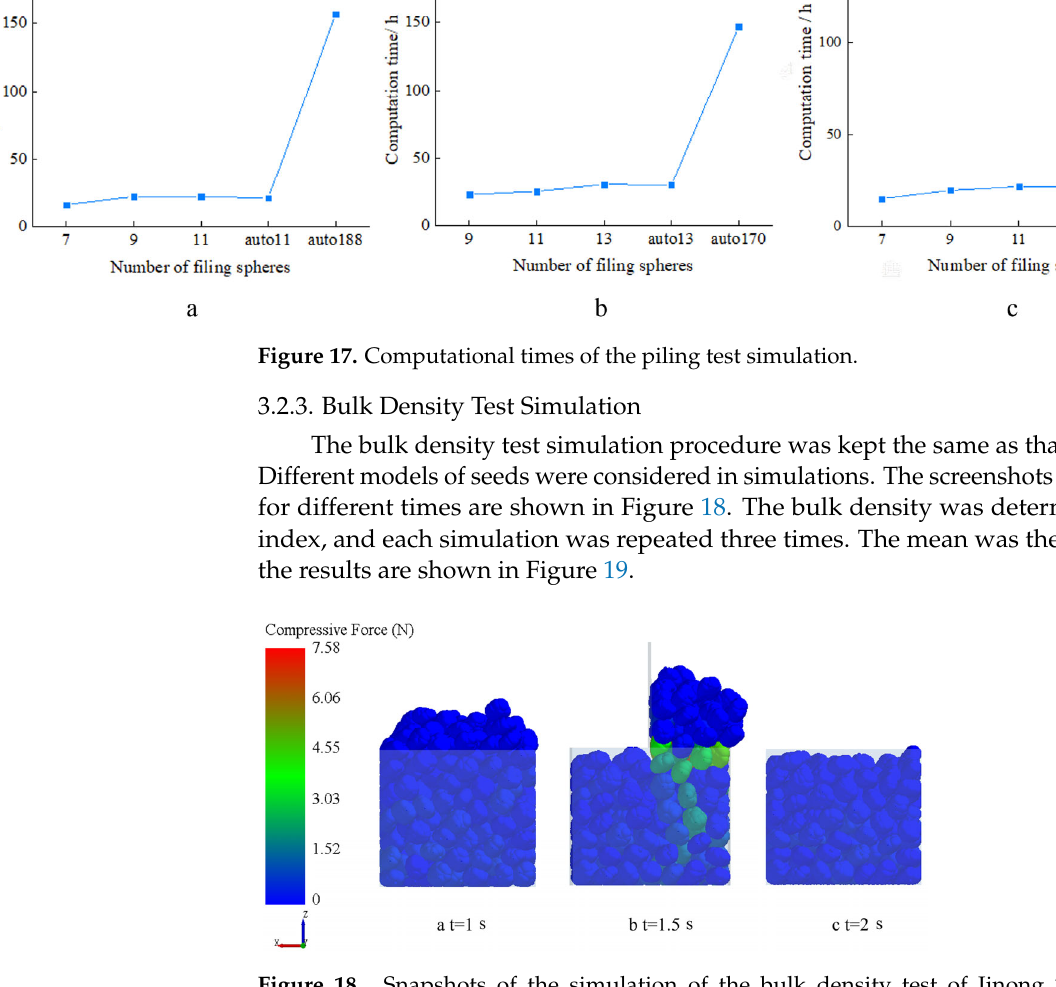
Figure 18. Snapshots of the simulation of the bulk density test of Jinong 3 seeds using the 11-sphere model.